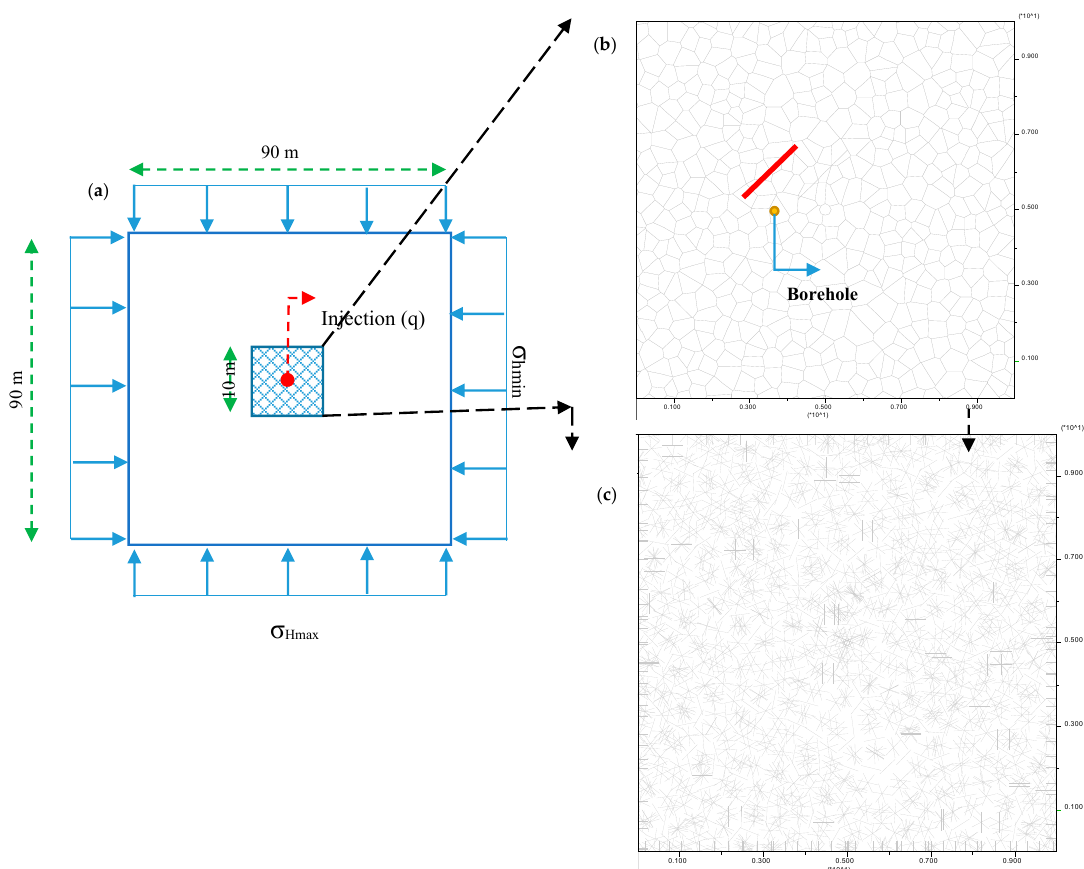
Fluids 2019 , 4 , x FOR PEER REVIEW Figure 3. ( a ) Dimensions in general numerical mode, ( b ) DFN and NF, ( c ) contact elements location.